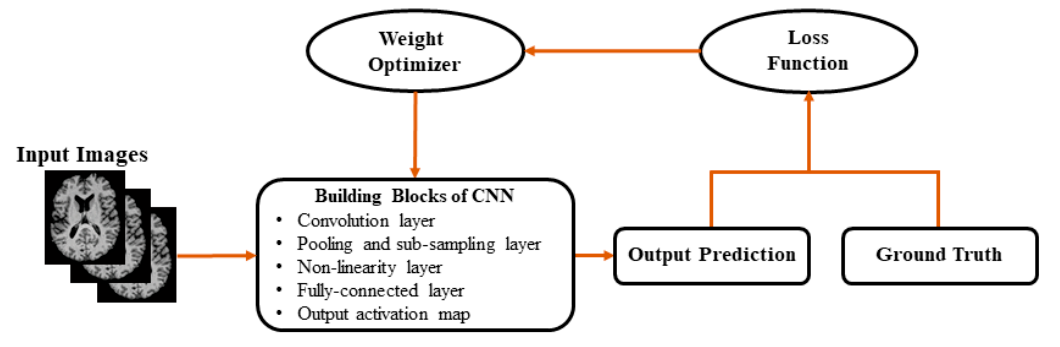
Figure 4. Generally used architecture of convolutional neural networks (CNNs).